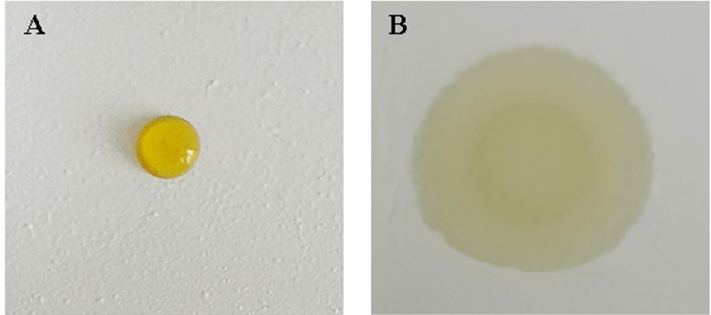
Figure 5 . The contrast diagram of effect of surfactant on serum scattering power: ( A ) without Figure 5. The contrast diagram of e ff ect of surfactant on serum scattering power: ( A ) without surfactant; surfactant; ( B ) with 35 μ L surfactant Tween-80. ( B ) with 35 µ L surfactant